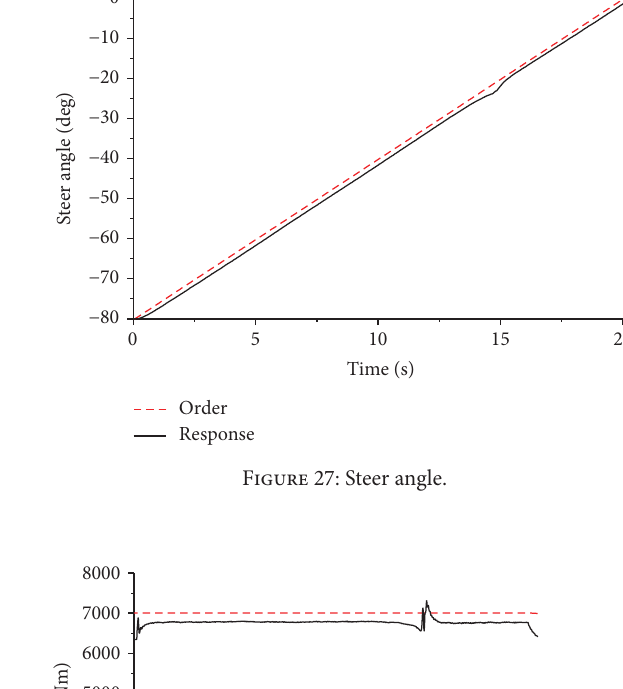
Figure 25: Pressure.